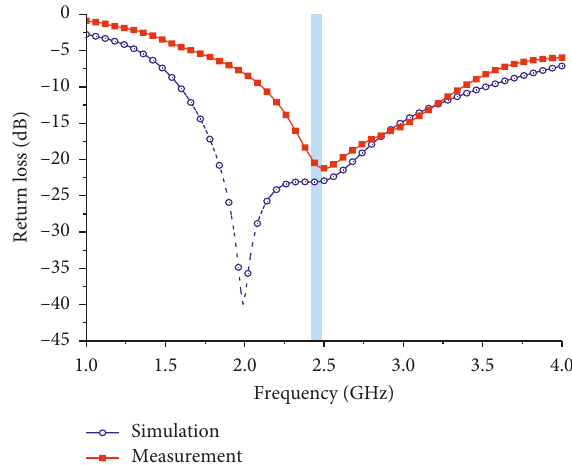
Figure 3: Return loss of measurement and simulation in liver